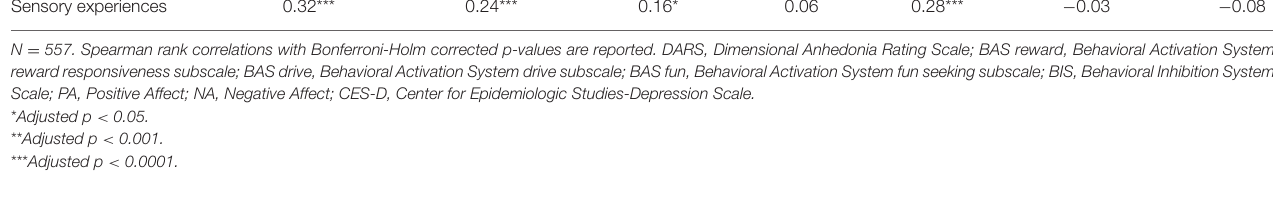
TABLE 5 | State anhedonia and depression severity sum score group comparisons. Measure